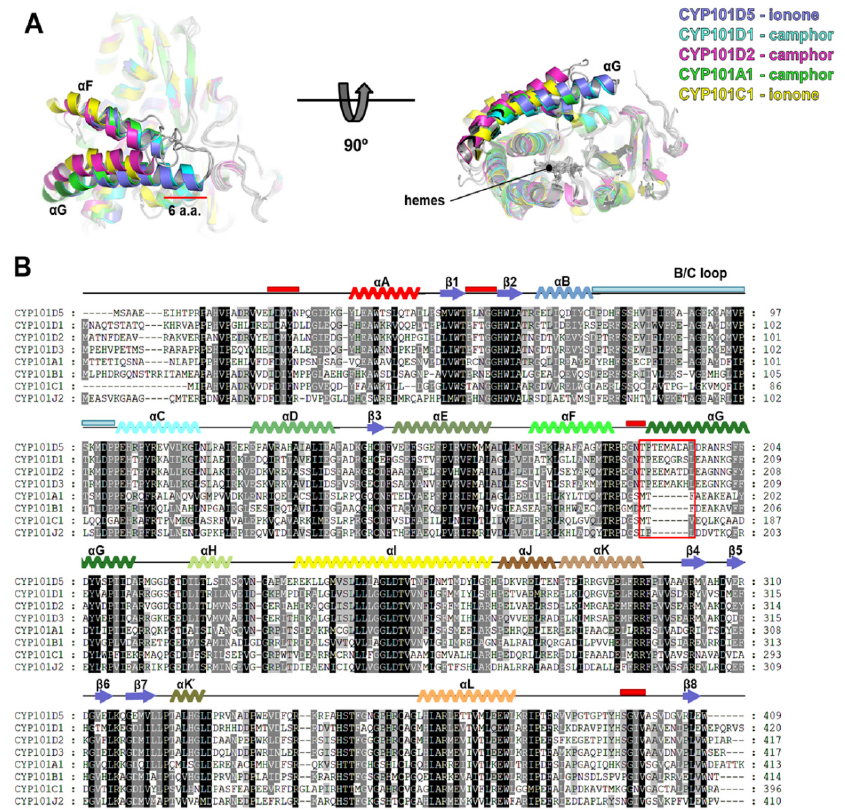
Figure 5. Structural superposition and multiple sequence alignment of CYP101D5 with CYP101 families; CYP101D1, CYP101D2, CYP101B1, and CYP101C1 from N. aromaticivorans DSM12444, CYP101D3 from Sphingomonas sp. SKA58, CYP101A1 from P. putida , and CYP101J2 from Sphingobium yanoikuyae . (A) Superposition of monomeric structures from CYP101 family highlighting α F, α G, and F/G loop. (B) The alignment was performed using ClustalW and visualized using GeneDoc. An additional six amino acids for the CYP101D subfamily are indicated with a red box. Loops co- ordinating the substrate binding site are indicated on the top of the sequences with red and cyan bars. The secondary structures are shown with simple diagrams on the top of the sequences based on the CYP101D5 structure and depicted with multiple colors. The color code for the secondary structure is the same as that of the CYP101D5 structure in Figure 4. Table 3. Substrate preference of CYP101 family proteins and the RMSD values compared to CYP101D5.